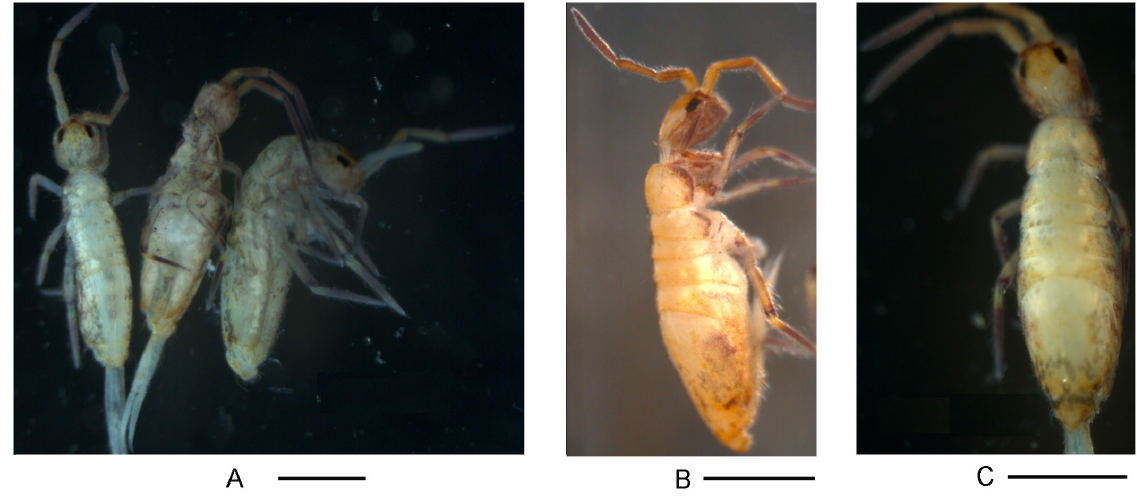
Fig. 1. Willowsia baoshanensis sp. nov. A−C . Habitus (A, C = paratypes; B = holotype) Scale bars: 500